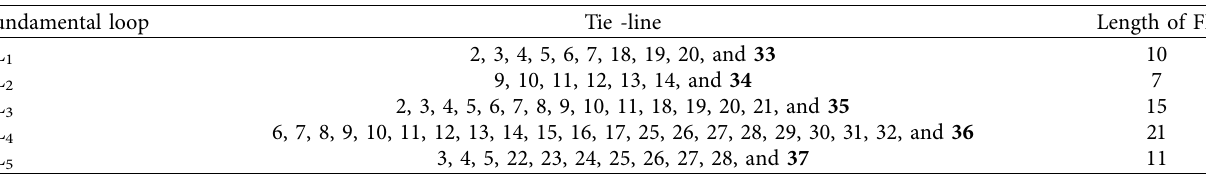
Figure 2: Single line diagram of 33-bus radial distribution system with a basic loop. Table 3: Fundamental Loop of IEEE 33 bus radial distribution system.